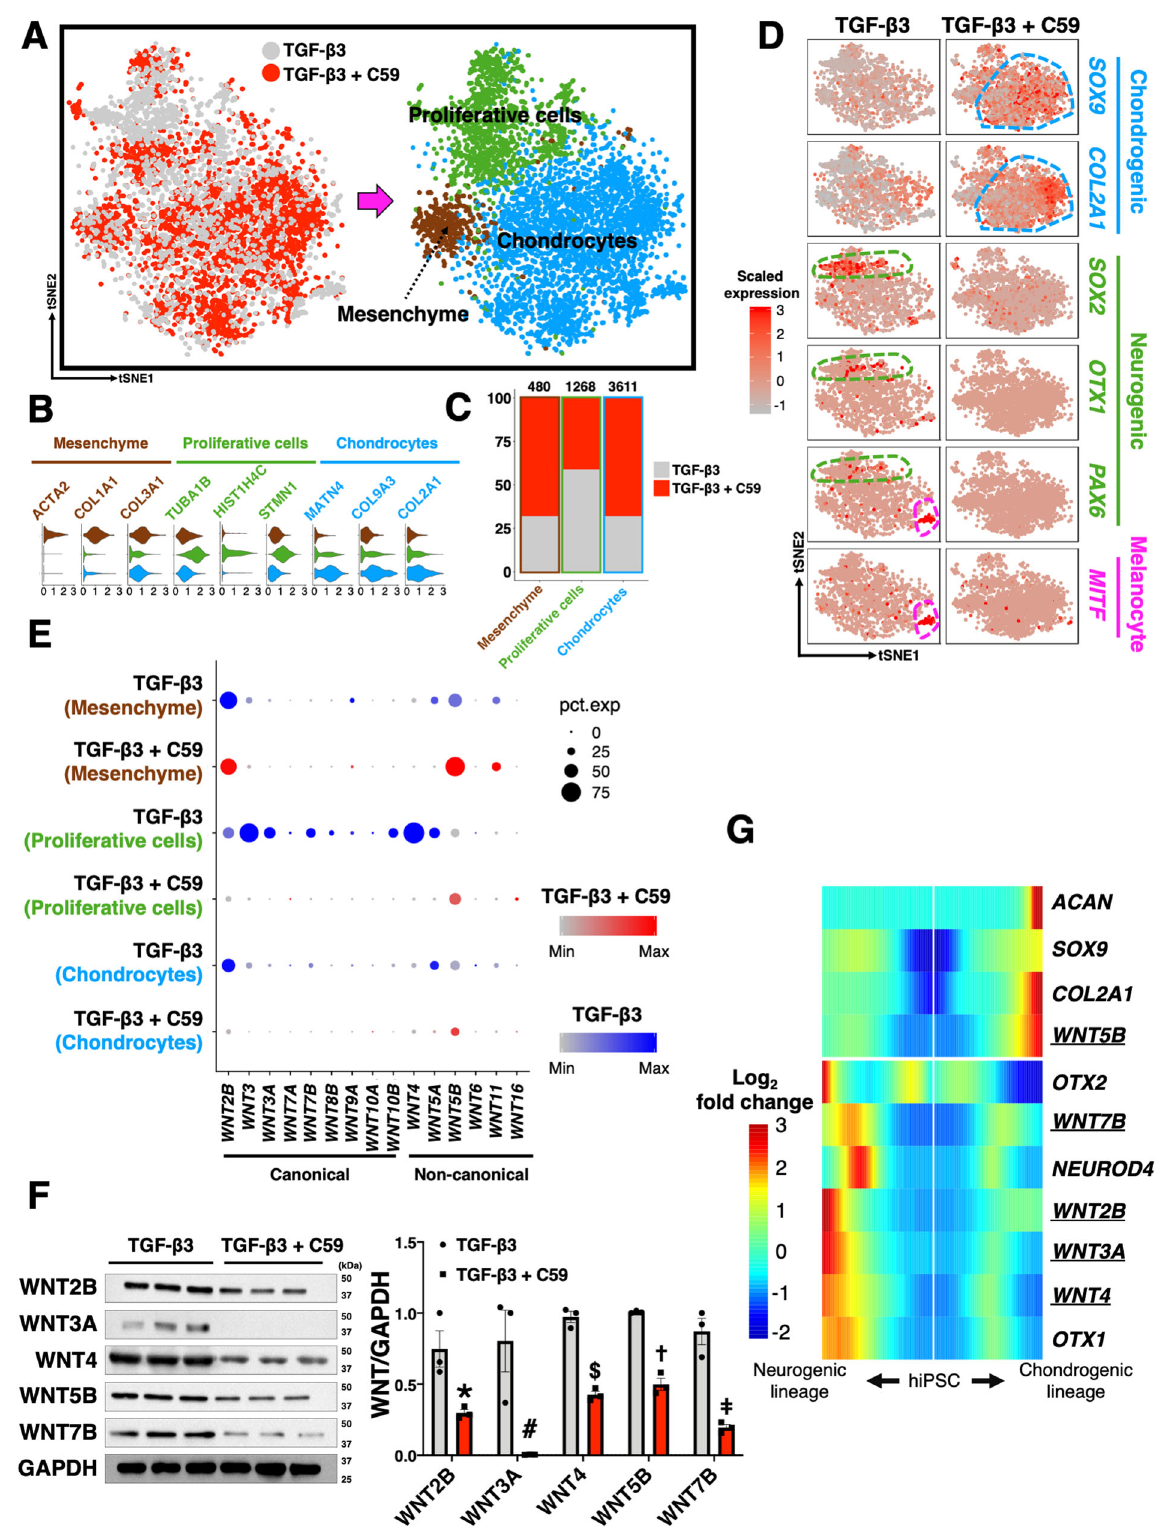
upregulated and downregulated DEGs. For instance, both cell populations showed upregulated expression of COL2A1 and JUNB , while exhibiting decreased expression of SOX4 and several ribosomal genes (Supplementary Fig. 8B). Interestingly, FRZB was only upregulated in the chondrocyte population upon C59